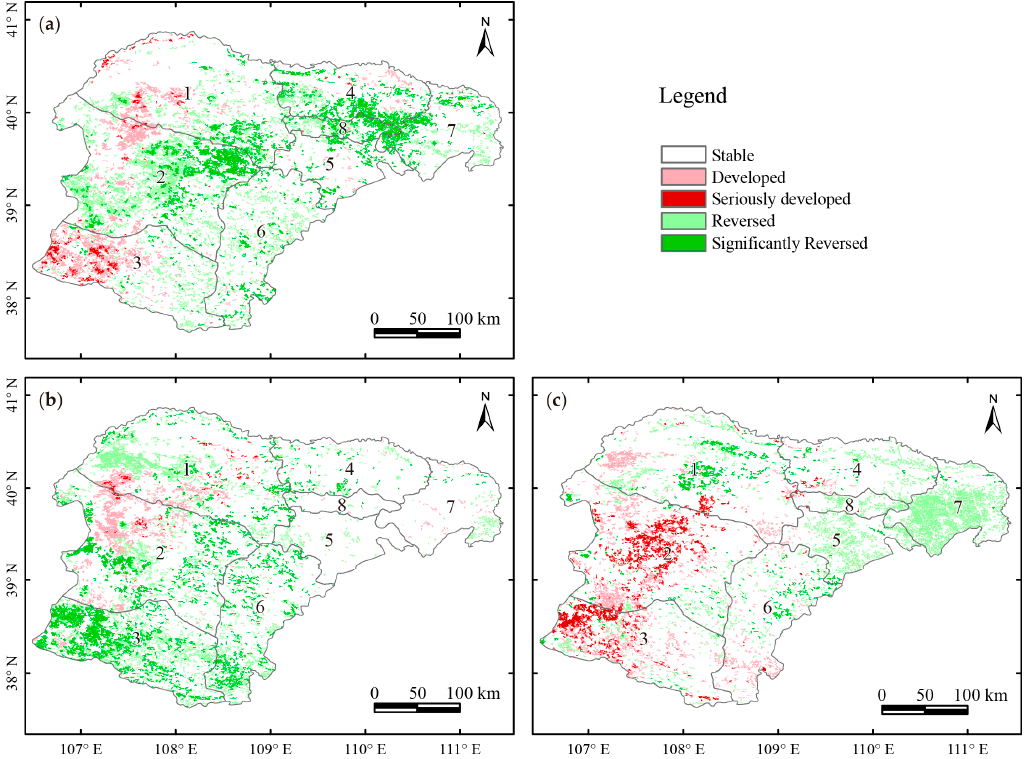
Figure 5. Spatial distribution of desertification dynamics for ( a ) 2000–2006; ( b ) 2006–2010 and ( c ) 2010–